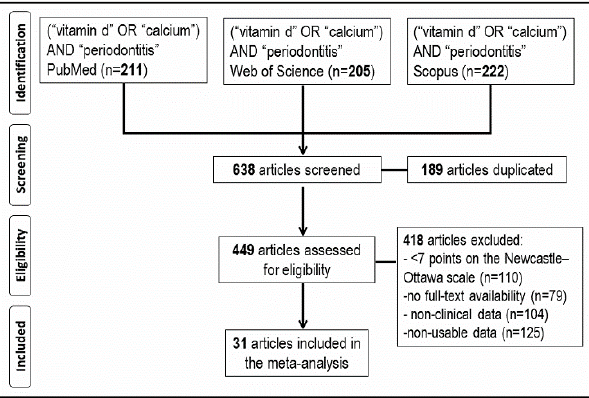
Figure 1 : Flow diagram of study